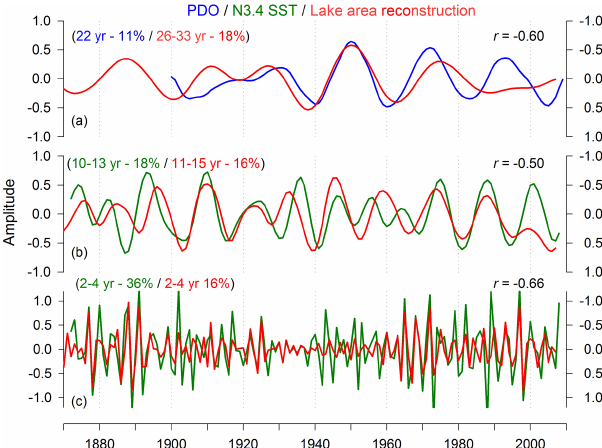
Figure 8. Comparisons between the waveforms of the lake area re- construction (red line), PDO (blue line) and the N3.4-SSTs (green line) extracted by Singular Spectrum Analysis (SSA) over the (a) 1900–2007 (PDO) and (b, c) 1872–2007 (N3.4-SSTs) intervals. The periodicities and percentage of variance explained by each fre- quency are indicated in parentheses. The correlation coefficients be- tween the two series are shown at the right corner. The PDO and N3.4-SSTs waveforms are shown inverse to facilitate the compari- son between records (right